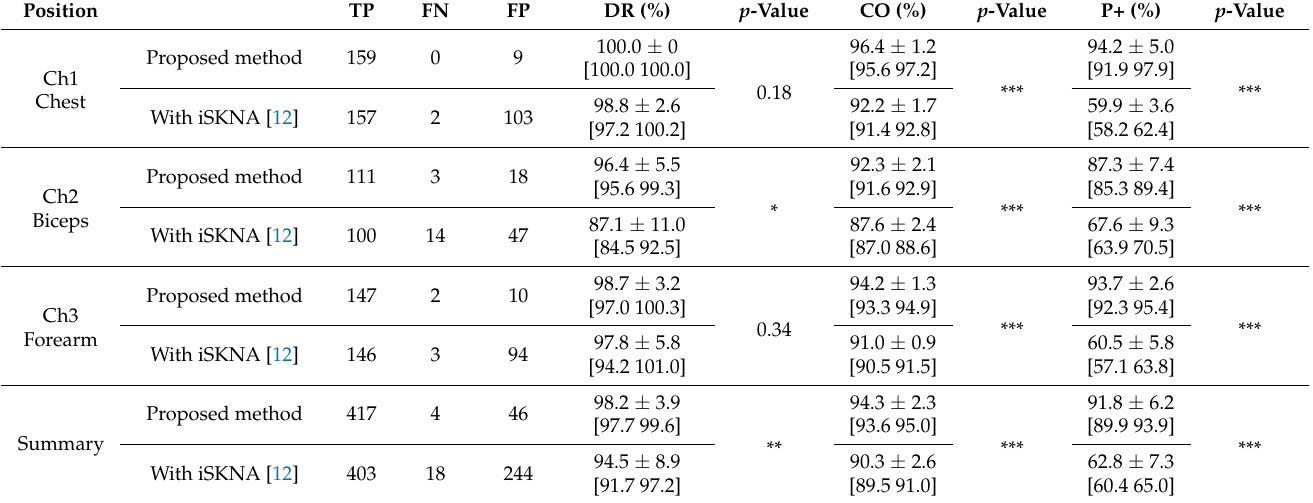
Table 2. The mean, standard deviation, and confidence interval (90% CI) of detection rate, coincidence, and precision of the proposed algorithm on the acquired signal of Experiment 1. * p < 0.05, ** p < 0.01, *** p <